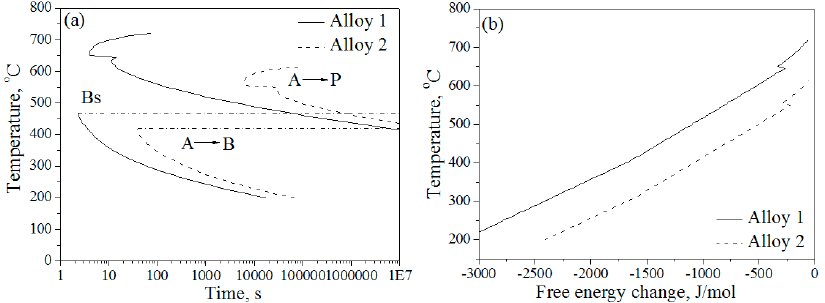
Figure 7. Effect of Co and Al addition on phase transformation; ( a ) the shifting of TTT (Time, Temperature, Transformation) curves, and ( b ) the free energy change.